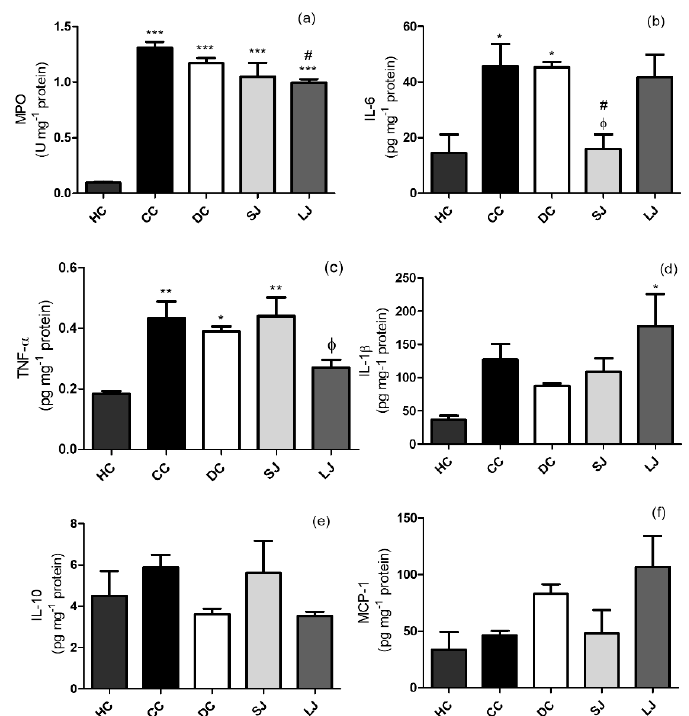
Figure 4. Inflammation markers. ( a ) Myeloperoxidase (MPO) activity (U) mg − 1 ; ( b ) IL-6; ( c ) tumor- necrotic factor- α (TNF- α ); ( d ) IL-1 β ; ( e ) IL-10; and ( f ) Monocyte chemoattractant protein-1 (MCP-1) pg mg − 1 protein in the colon. HC = healthy control; CC = colitis control; DC = drug (mesalazine) control; SJ = short-term EJP extract treatment; and LJ = long-term EJP extract treatment. Aqueous extract of Jaboticaba peel (EJP). Results are expressed as the mean ± standard error ( n = 3–5). * Indicates significant difference from HC group, # from CC group, and Φ from DC by one-way ANOVA and Tukey’s test (1 code = p < 0.05; 2 codes = p < 0.01; and 3 codes = p < 0.001).